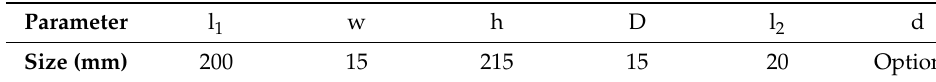
Figure 1. Battery thermal management system model. Table 2. The size of hollow aluminum plate.